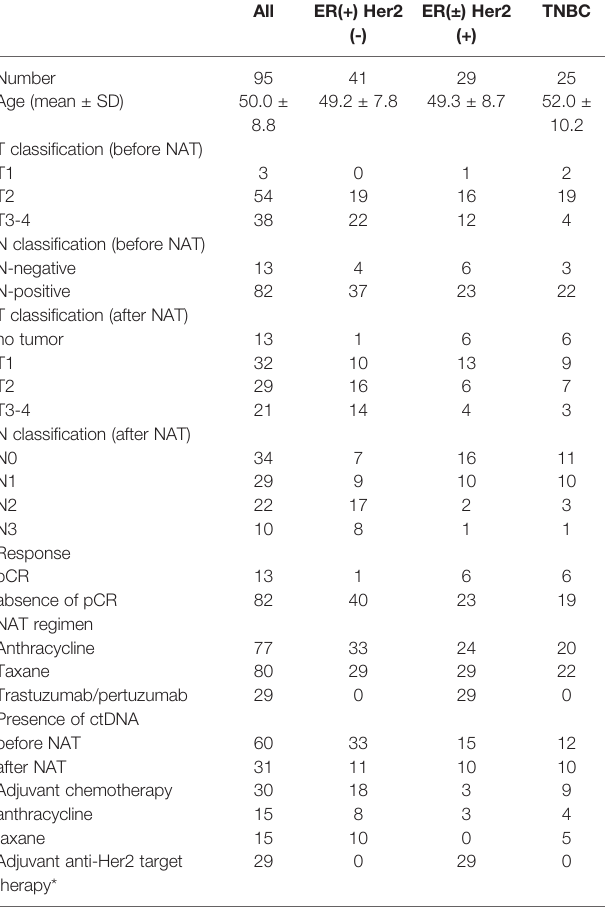
TABLE 1 | Clinical and pathologic characteristics of enrolled patients strati fi ed by immunophenotypes.